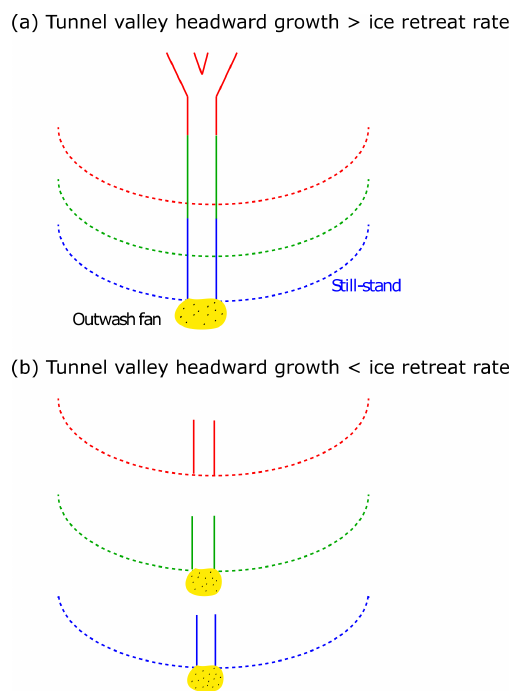
Figure 17. Cartoon demonstrating the dependence of tunnel valley evolution (by headward growth) on ice margin retreat rate. (a) If headward growth of a tunnel valley is faster than the rate of ice re- treat the valley will be able to extend continuously up-glacier and its length will only be limited by water supply and hydraulic properties of the bed. (b) If, however, headward growth of a tunnel valley is slower than the rate of ice retreat the valley is likely to be discontin- uous, only being able to form and extend up-ice during slow-downs or pauses in retreat.